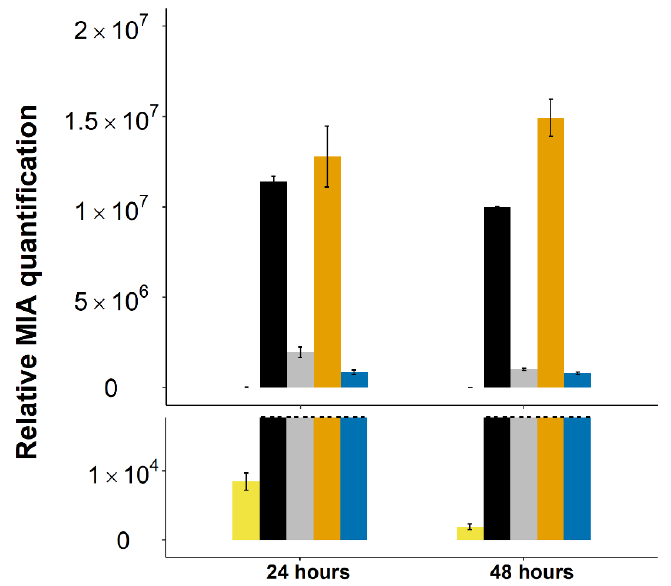
Figure 3. Evolution of MIA biosynthetic intermediates in the medium culture of yeast harboring episomal plasmids containing two copies of T16H2 and one copy of 16OMT and T3O (2(T16H2)_T3O strain). The dashed line represents the scale cut for the visualization of accumulated intermediates of low volume. Alkaloids were quantified by UPLC ‐ MS in the yeast culture medium 24 h post ‐ feeding with tabersonine (250 μ M). Light yellow = tabersonine (tab), black = 16 ‐ hydroxytabersonine (16OHtab), grey = 16 ‐ methoxytabersonine (16MeOtab), dark yellow = 16 ‐ methoxytabersonine epoxide (16MeOtab_epoxi), blue = tabersonine epoxide. Error bars correspond to the standard error of biological replicates ( n = 3). MIA composition of the yeast culture medium is expressed as relative peak areas.